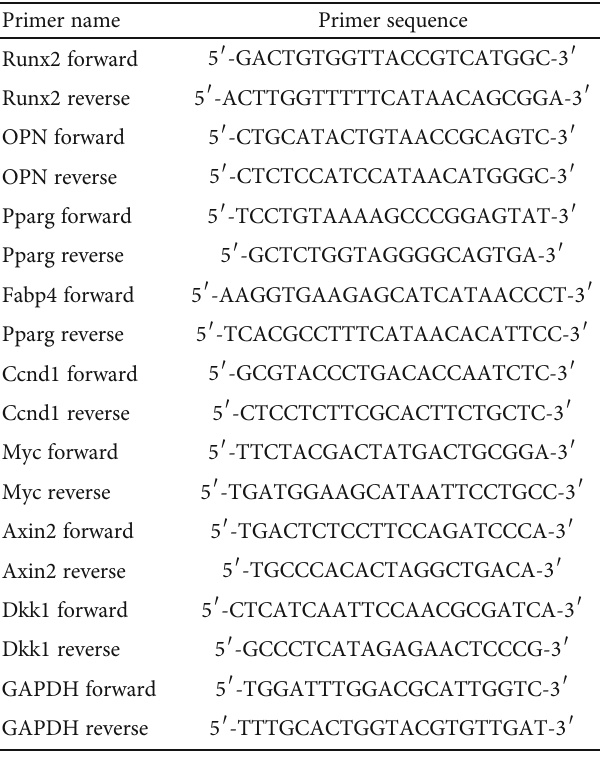
Table 1: Primer information for